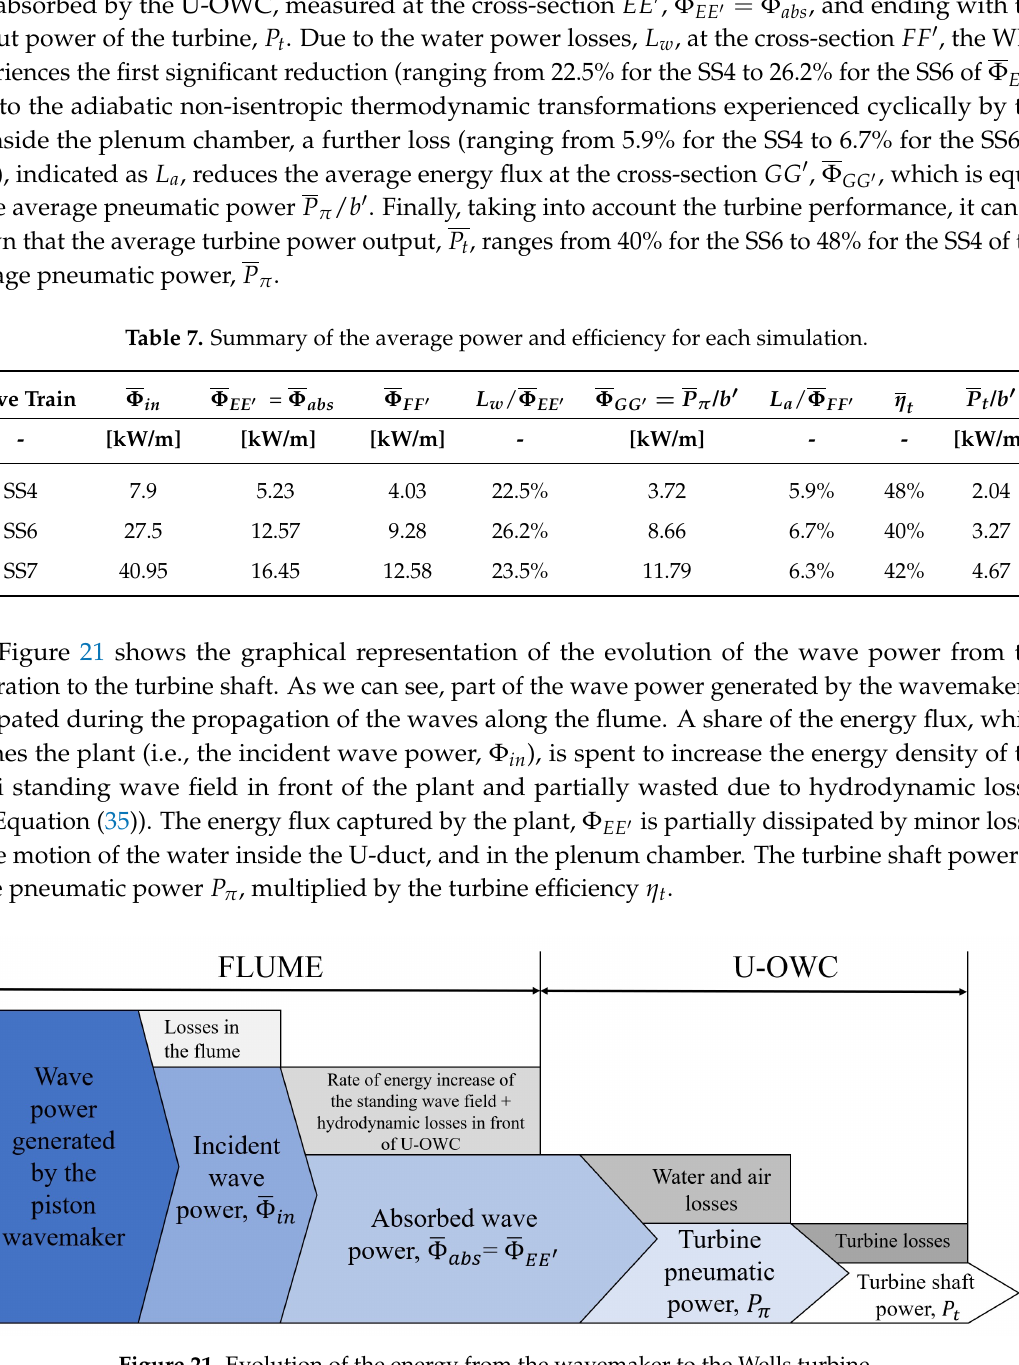
Figure 21. Evolution of the energy from the wavemaker to the Wells